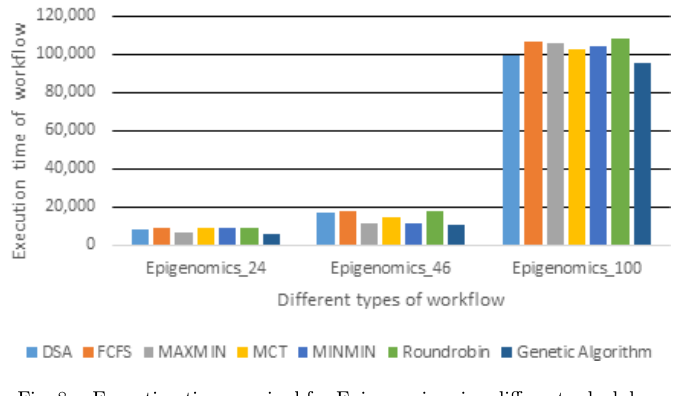
Fig. 8. Execution time required for Epigenomic using di®erent schedulers.